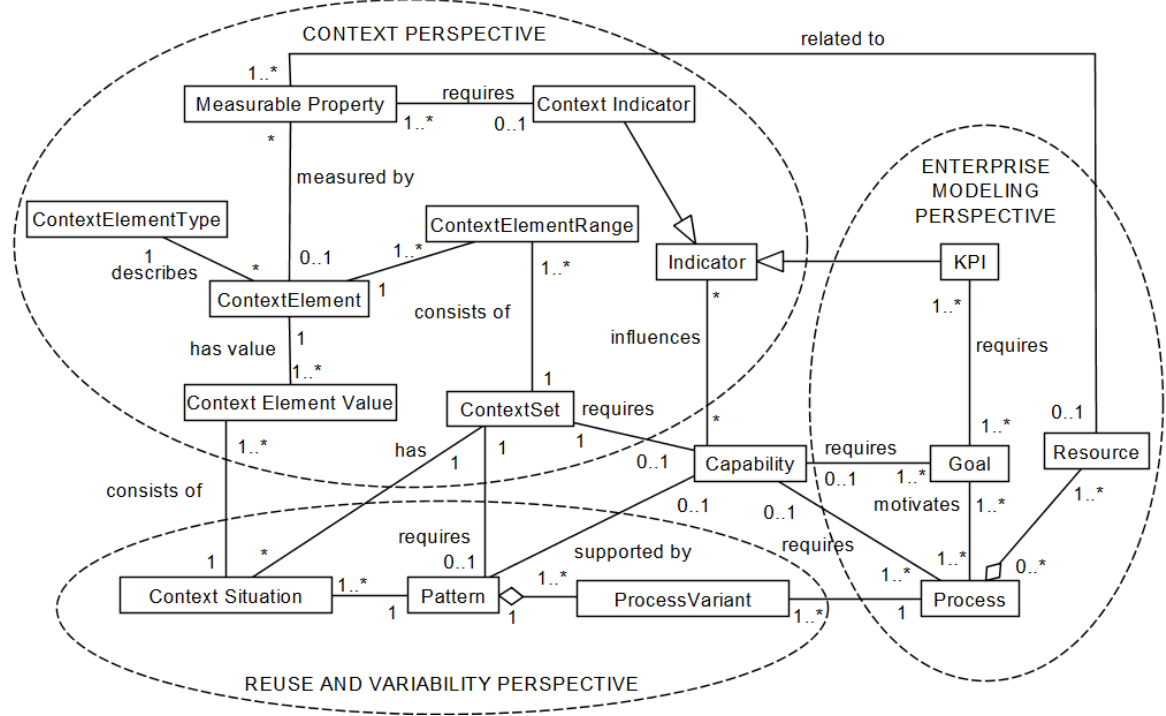
Figure 1. Uncluttered CaaS metamodel and semantic perspectives (remodeled from